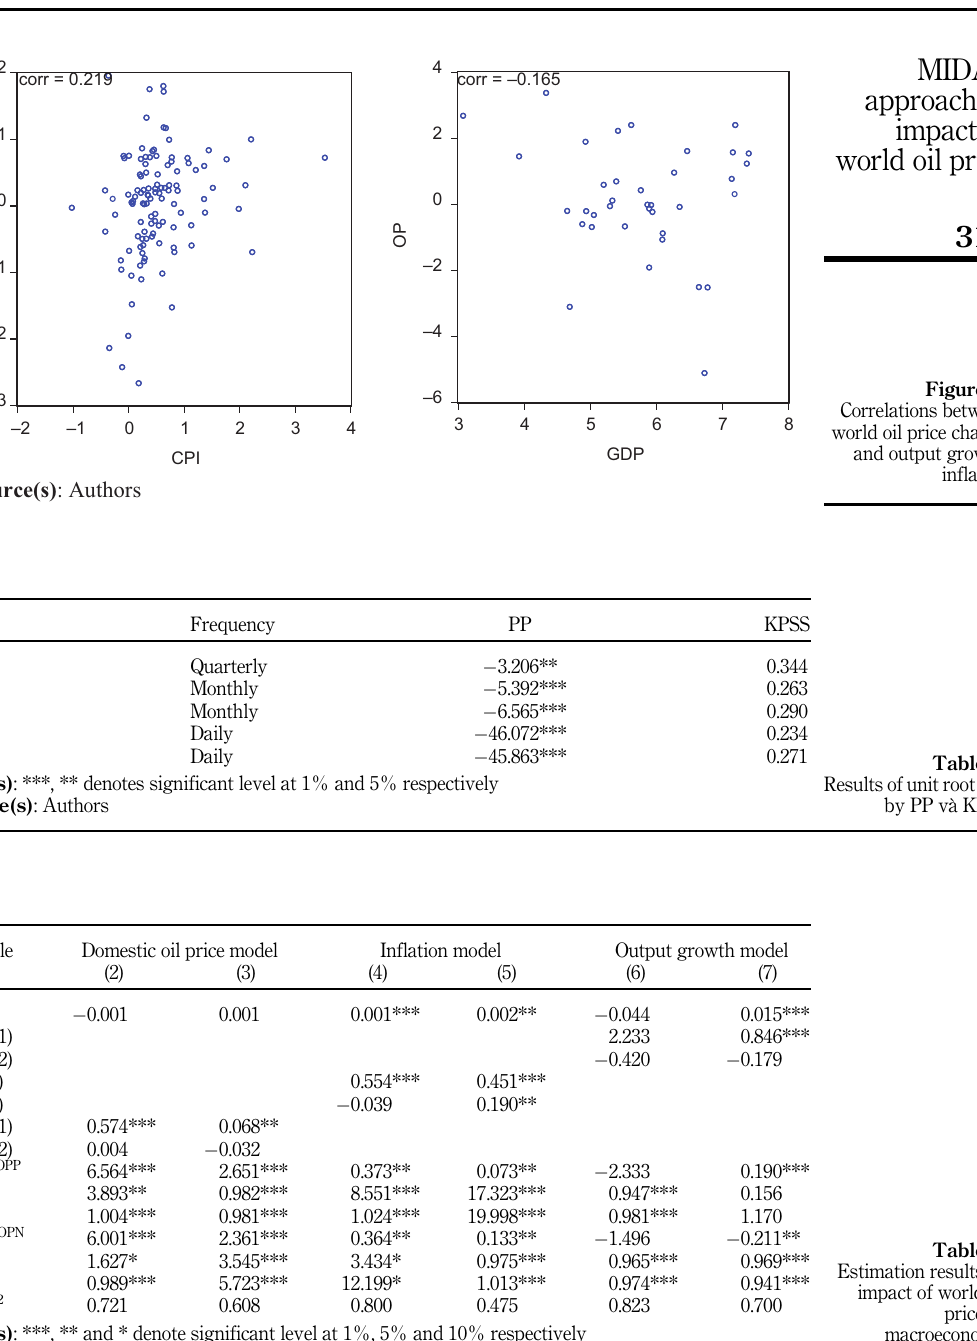
Table 3. Estimation results